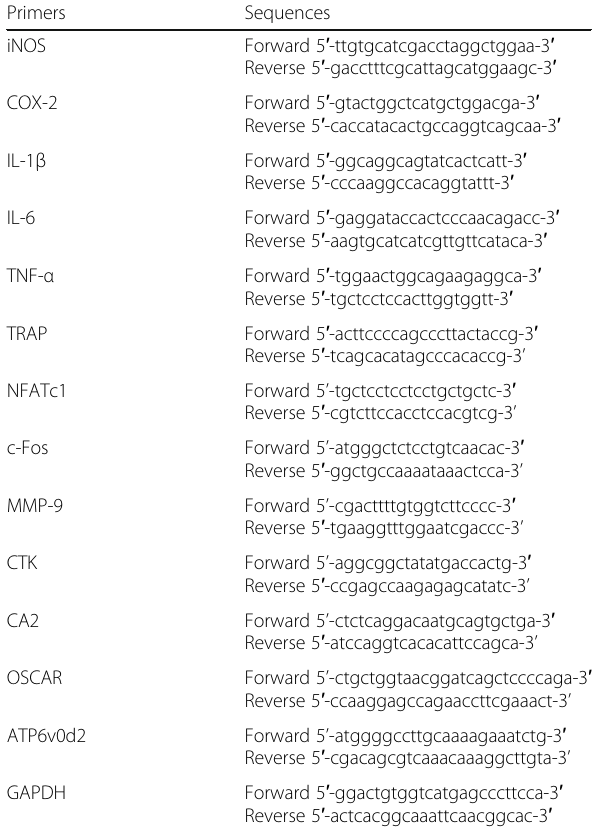
Table 1 The primer sequences used in this study Primers